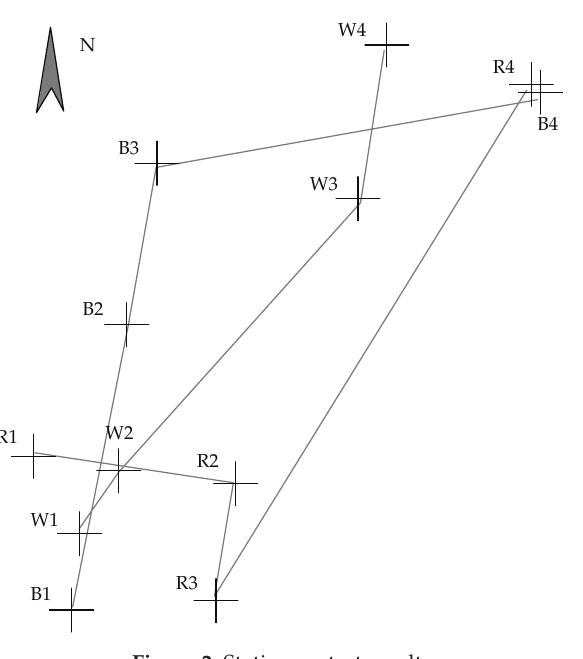
Figure 2: Stationary test result.